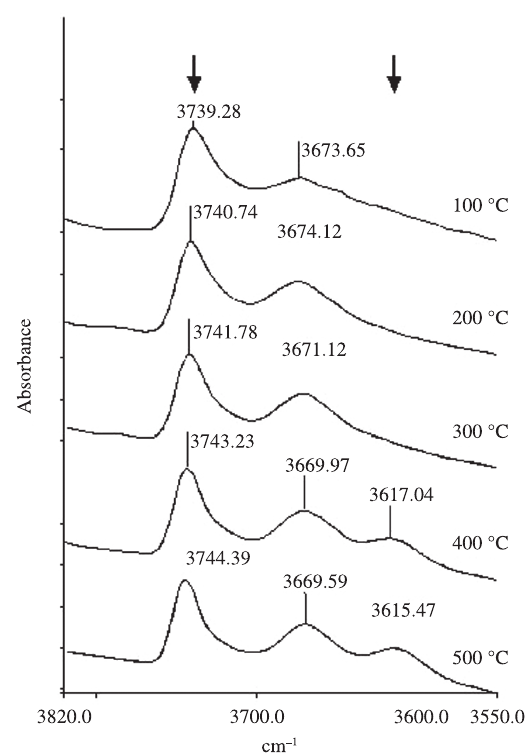
Figure 4. Difference spectra of the solids NHT, HT560 and HT760 minus HT960 in the FTIR region of the deformation vibration the adsorbed water.